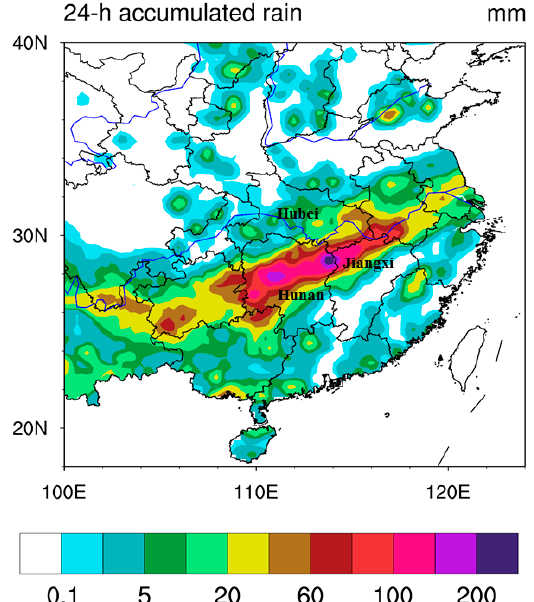
Figure 8. The 24-h accumulated observed rainfall (mm) from 0000 UTC 30 June 2017 to 0000 UTC 1 July 2017.